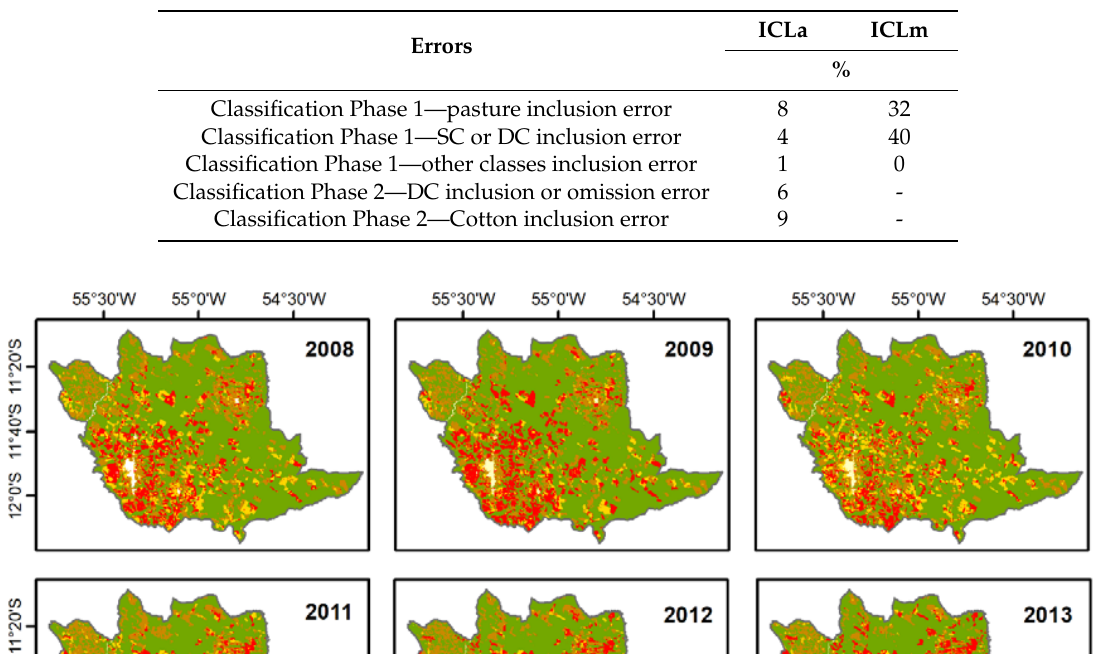
Table 5. Integrated crop–livestock classification errors origins.